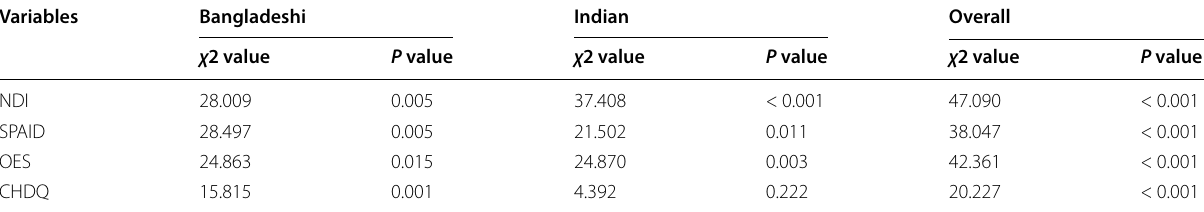
Table 3 Association between smartphone addiction and neck, shoulder, elbow, and hand pain